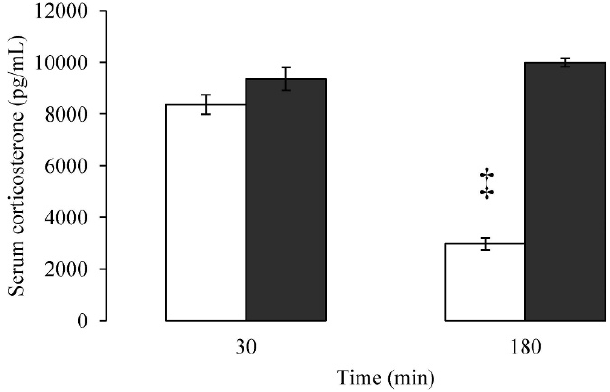
Figure 4 - Enzyme-linked immunosorbent assay for the serum corticosterone level in brain-dead (white columns) and sham- operated (gray columns) rats 30 and 180 minutes after the surgical procedure. The data are presented as the mean ¡ SEM for 10 rats/group. ANOVA p , 0.0001. { p , 0.0001 vs. SH at the same